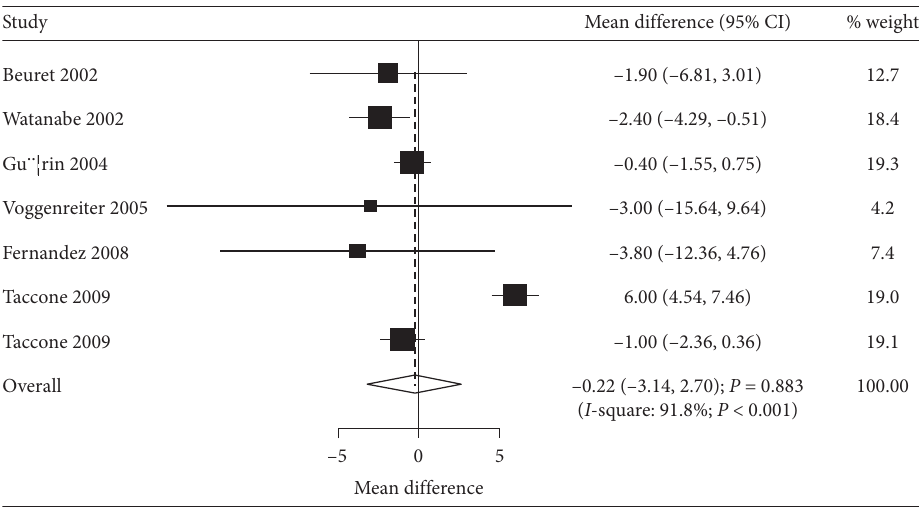
Figure 3: Prone versus supine position ventilation on mechanical ventilation duration.